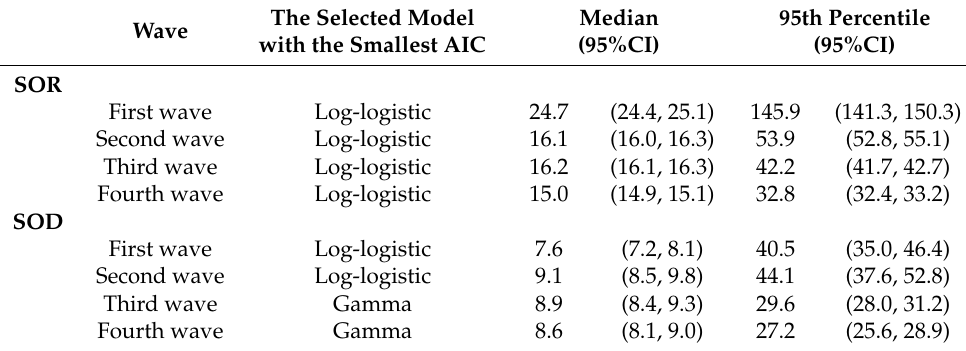
Table 4. The median estimates of SOR and SOD in the four